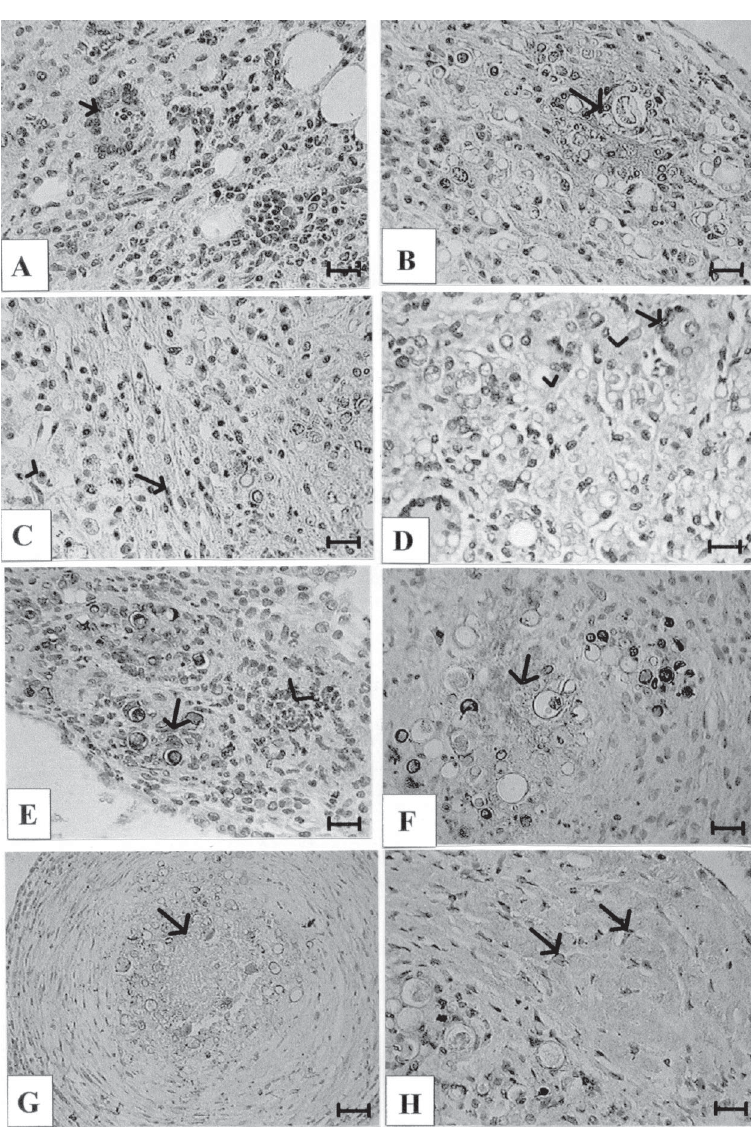
Figure 1. Immunohistochemical analysis of transforming growth factor-ß (TGF-ß) in granu- lomatous lesions. A , Positive reaction of macrophages and multinucleated giant (arrow) cells surrouding fungal cells in susceptible mice after 15 days of infection (bar = 25 µm). B , TGF-ß positive macrophages (arrow) in susceptible mice after 120 days of infection (bar = 25 µm). C , Fibroblasts (arrow) and plasma cells (arrowhead) positively labeled in susceptible mice after 120 days of infection (bar = 25 µm). D , Both multinucleated giant cells (arrow) and stained tissue (arrowheads) surrounding yeast cells in susceptible mice after 150 days of infection (bar = 25 µm). E , Pb18 surrounded by positive macrophages (arrow) and presence of TGF-ß-negative polymorphonuclear neutrophils (arrowhead) in resistant mice after 15 days of infection (bar = 25 µm). F , Staining of the initial area of fibrosis (arrow) in a lesion of resistant mice after 120 days of infection (bar = 25 µm). G , Positive reaction in the central necrosis (arrow) of a concentric lesion in resistant mice after 150 days of infection (bar = 31.25 µm). H , Pseudoxanthomatous macrophages (arrows) in a residual lesion in resistant mice after 150 days of infection (bar = 25 µm). Streptavidin-biotin-peroxidase reaction; original magnifications: 250X (G); 400X (A, B, C, D, E, F and